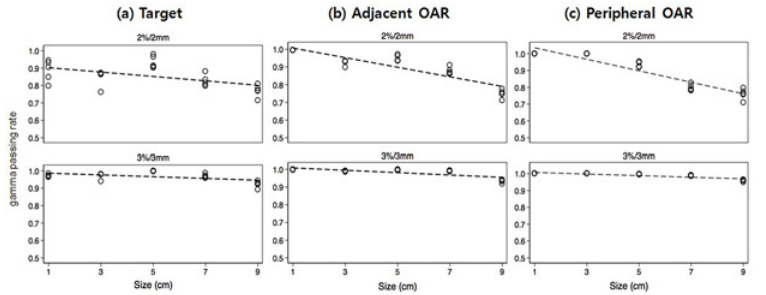
Fig 4. Variation of 3D gamma passing rates for (a) target, (b) adjacent organ at risk (OAR), and (c) peripheral OAR with various target sizes. The gamma passing rates were calculated with both the 3%/3 mm criterion (upper graph) and the 2%/2 mm criterion (lower graph) in absolute doses with a threshold of 5%. The 3D gamma passing rate decreased as the target size increased in all specific regions of interest.